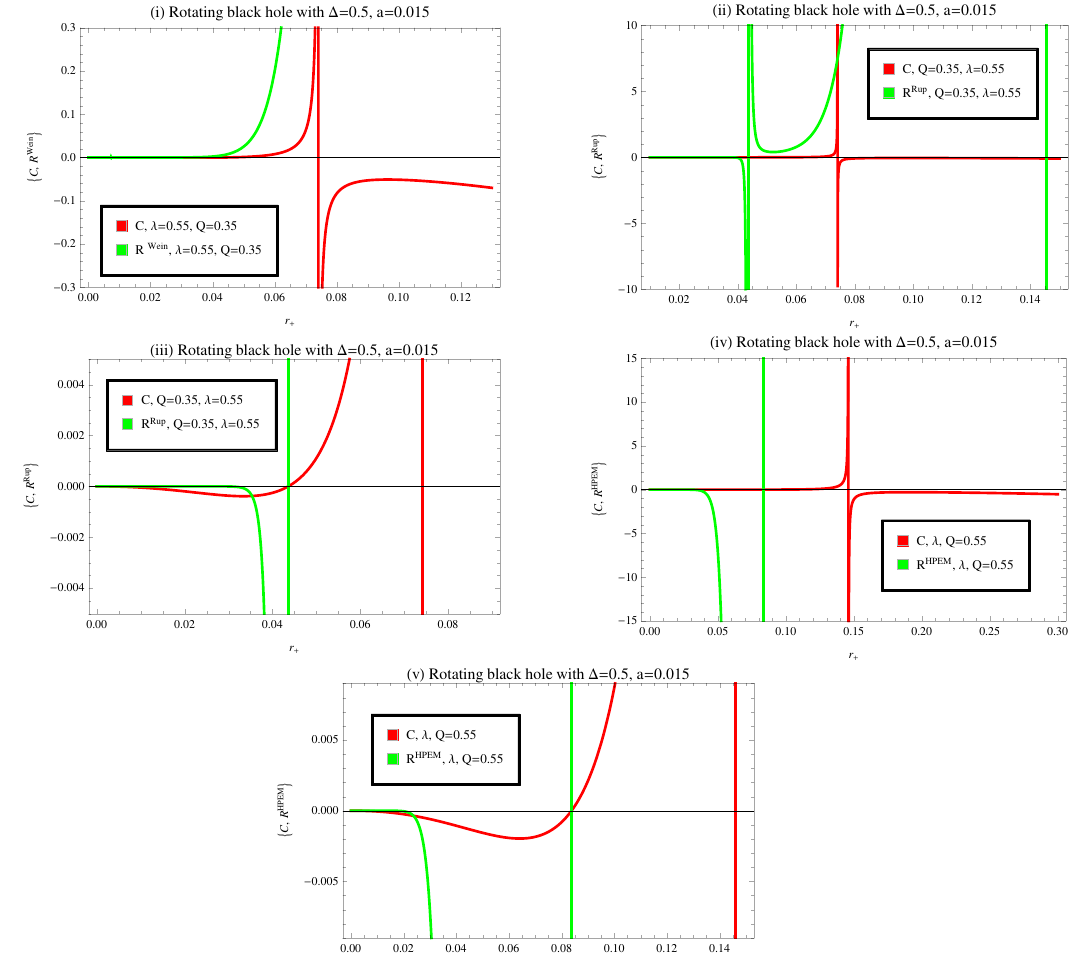
Figure 10. Combine plots of heat capacity C v and Ricci scalar R of Ruppeiner, Weinhold, and HPEM metric versus event horizon radius r +